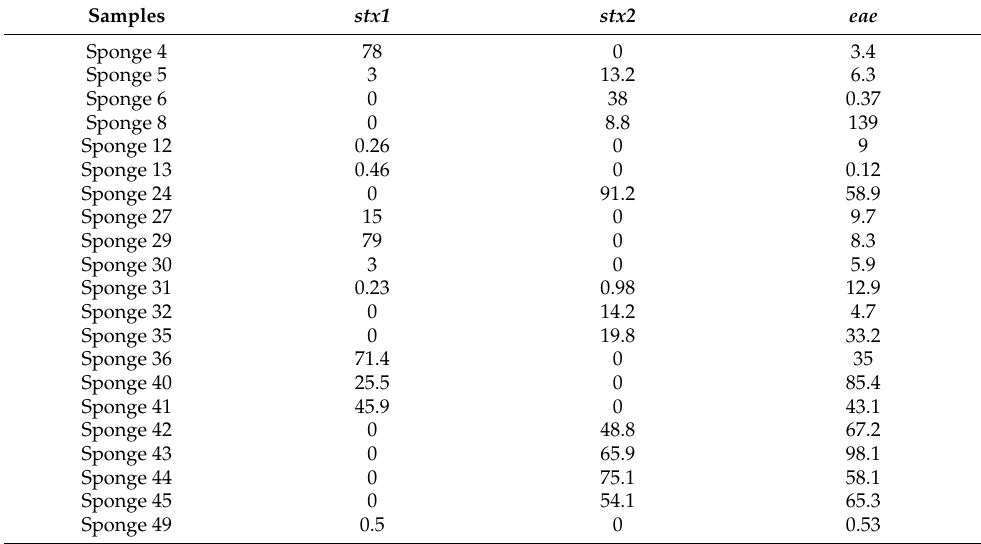
Table 5. Number of copies/ µ L detected by droplet digital PCR in sponges used for the microbiological control of carcasses of cattle slaughtered in various areas of the Campania region. All sponges were incubated at 37 ◦ C for 9